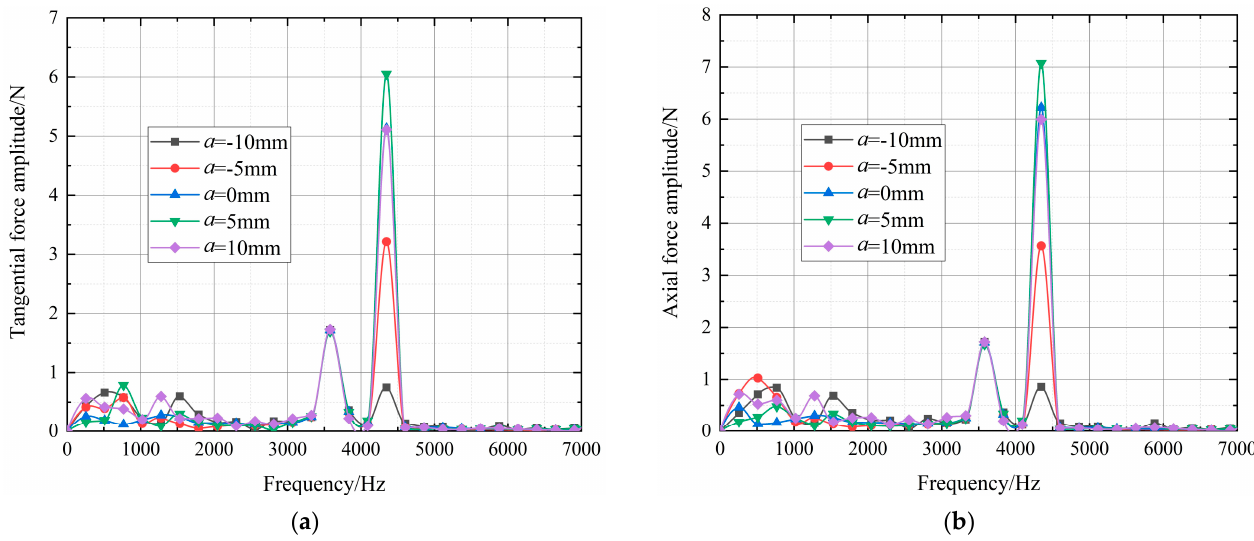
Figure 18. Frequency domain distribution of the aerodynamic exciting force under near-blockage